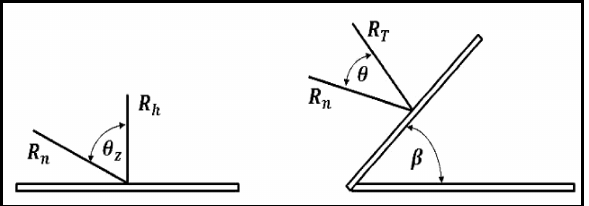
Figure 1. Solar radiation on a tilted and horizontal surfaces